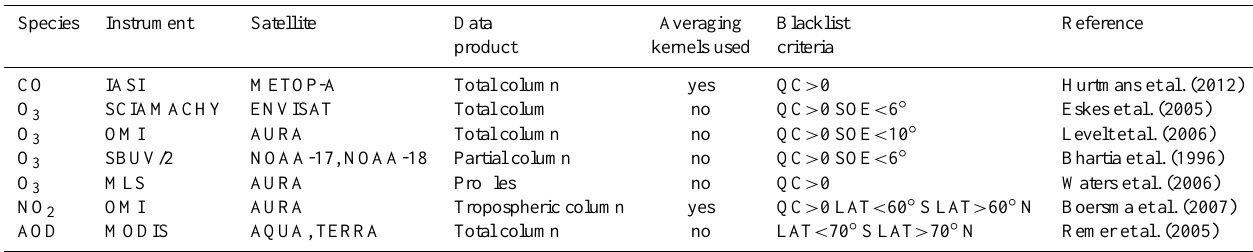
Table 1. Summary of satellite data used in the assimilation. Blacklist criteria: variational quality control (QC), Solar Elevation (SOE) and latitude